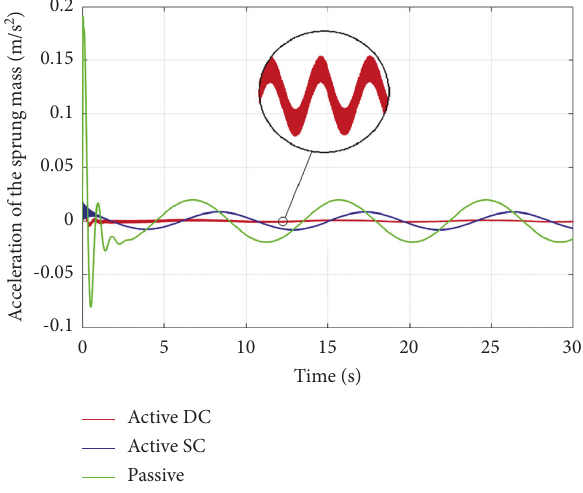
Figure 6: Acceleration of the sprung mass.